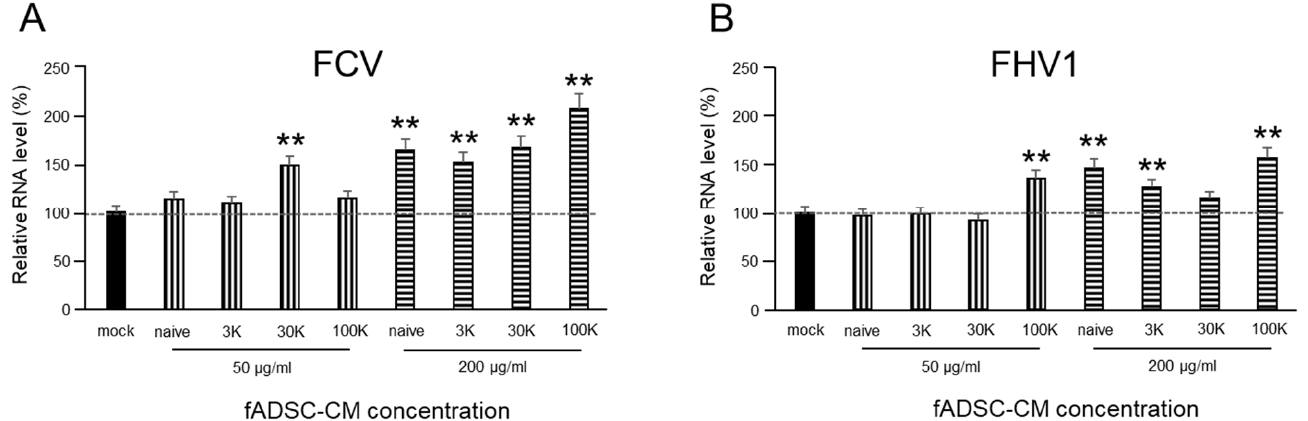
Figure 3. Evaluation of the effects of fAD-MSC-CM on viral entry ( A ) Relative FCV mRNA lev- els in CRFK cells. ( B ) Relative FHV1 mRNA levels in CRFK cells. Data are expressed as the mean ± standard deviation. Asterisks indicate significant differences compared with mock-treated group (**, p <